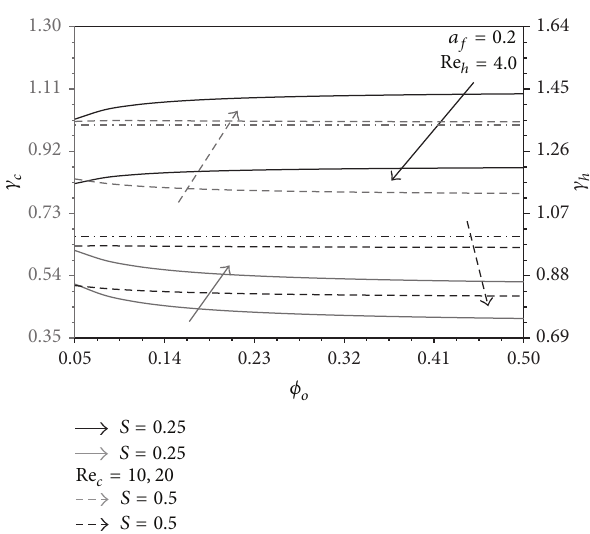
Figure 9: Effects of 𝜙 𝑜 and Re 𝑐 on 𝛾 ℎ and 𝛾 𝑐 .